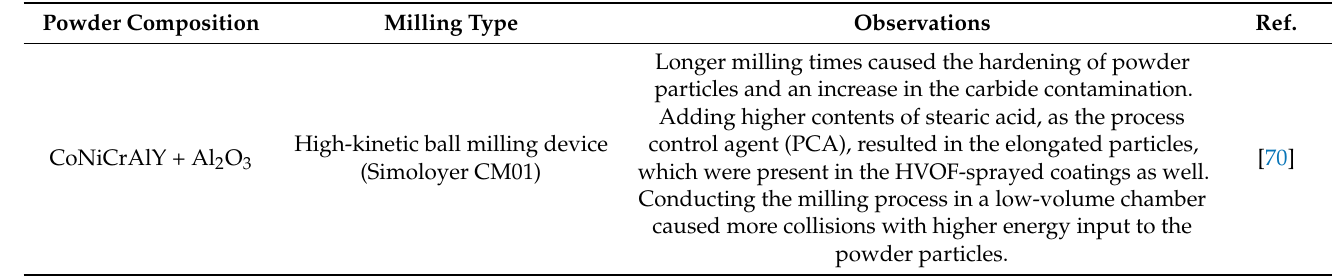
Figure 4. Schematic representing the deformation characteristics of powder particles upon collisions and the formation mechanism of composite powder. Table 3. Some highlights of the literature on the development of modified MCrAlY-based powders via mechanical milling